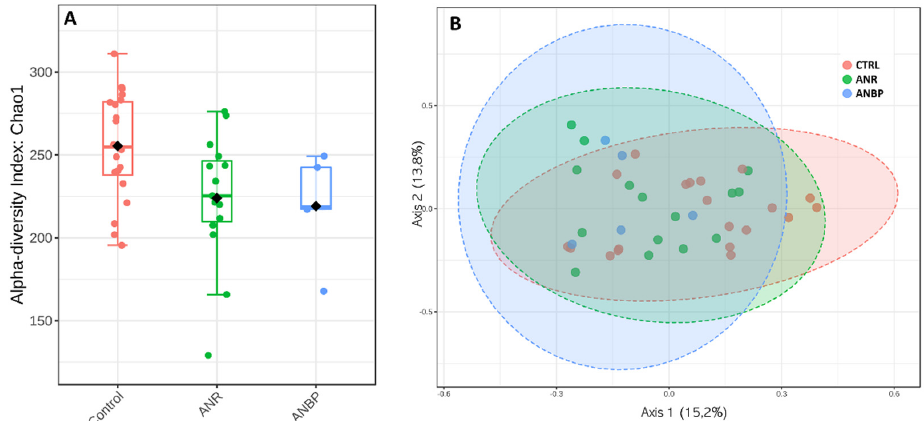
Figure 3. ( A ) Alpha diversity according to Chao index in control (CTRL), restricting (ANR), and binge-purging (ANBP) anorexia nervosa patients. ( B ) Microbiome beta-diversity represented in terms of non-metric multidimensional scaling.